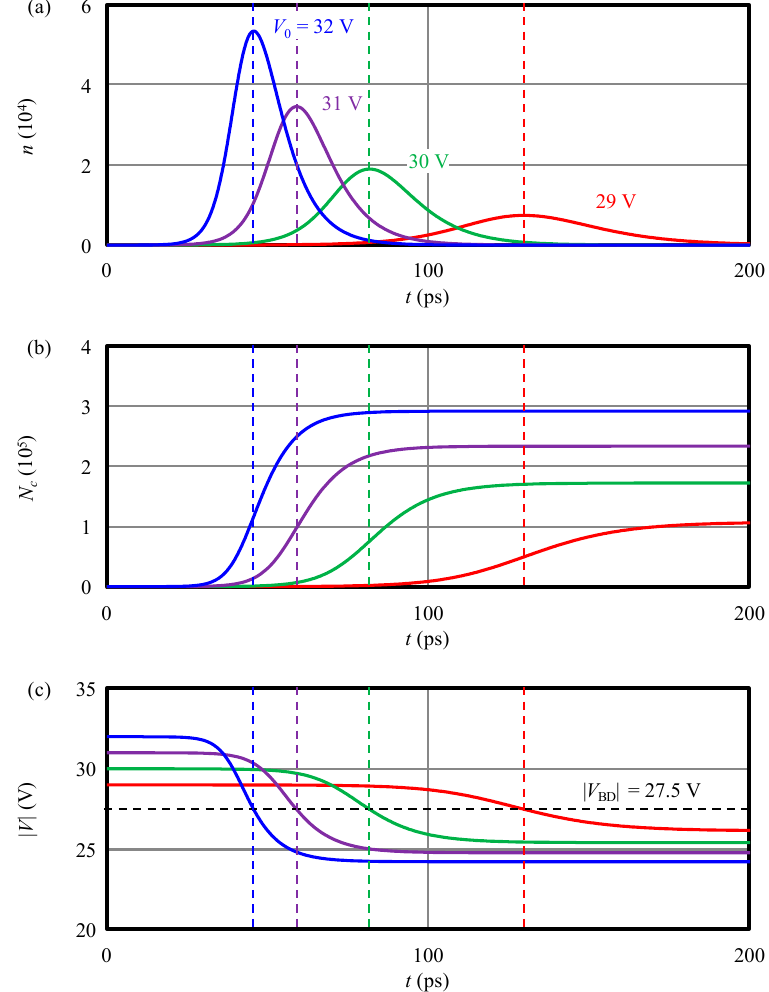
Figure 2. Calculated parameters in time domain. The time increment is 0.1 ps. ( a ) Time evolutions of the electron number in the i -region, ( b ) the number of accumulated electrons in the series capacitance, and ( c ) reverse bias of SPAD. The red, green, purple, and blue lines denote, respectively, the results with initial biases 29 V, 30 V, 31 V, and 32 V. A horizontal dashed line in ( c ) indicates |𝑉 (cid:3003)(cid:3005) | and vertical dashed lines show the times when d n /d t = 0 or |𝑉(𝑡)| = |𝑉 (cid:3003)(cid:3005) | .